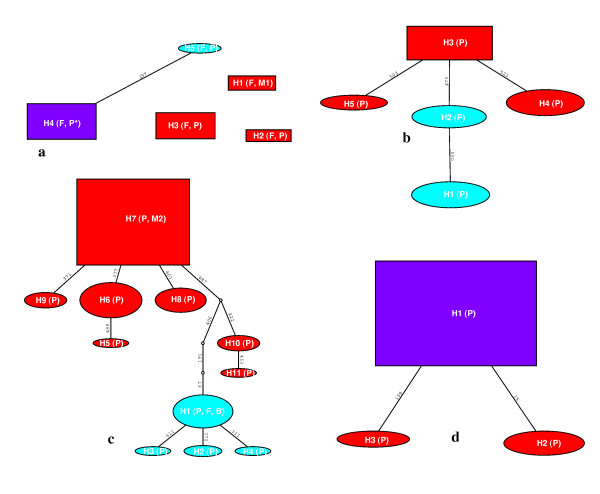
TCS haplotype networks based on non-recombining ITS sequences. a. C. arcuatorum. b. C. aureofulvus. c. C. elegantior. d. C. napus. Parsimony probabilities were set at 95%. Sizes of circular and rectangular areas are proportional to the number of individuals with that haplotype. Haplotypes with a blue background are from the Old World and those with red backgrounds are from the New World. Haplotypes comprising New and Old World populations are indicated by lilac backgrounds. Distributions of ecological and morphological features are abbreviated as follows: F, Fagaceae; P*, Pinaceae (pure stand in Wyoming); P, Pinaceae; B, Betulaceae, M1, populations of C. arcuatorum with larger spores; M2, some populations of C. elegantior with sulphur yellow veil and lacking of veil patches on the pileus surface.